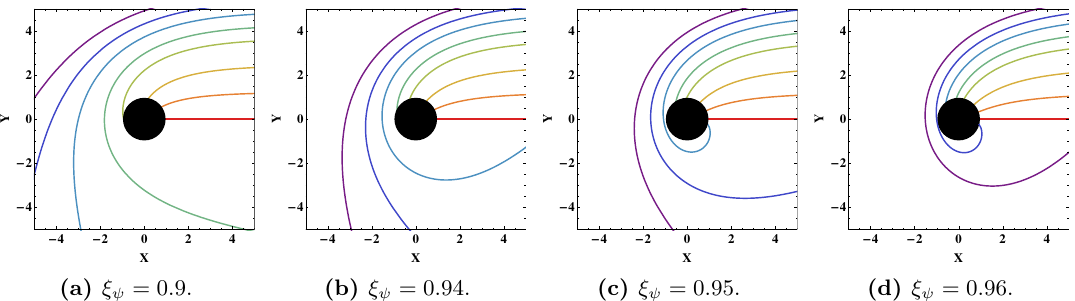
Figure 2 . Propagation of photon with di(cid:11)erent (cid:24) in the rotating squashed KK black hole